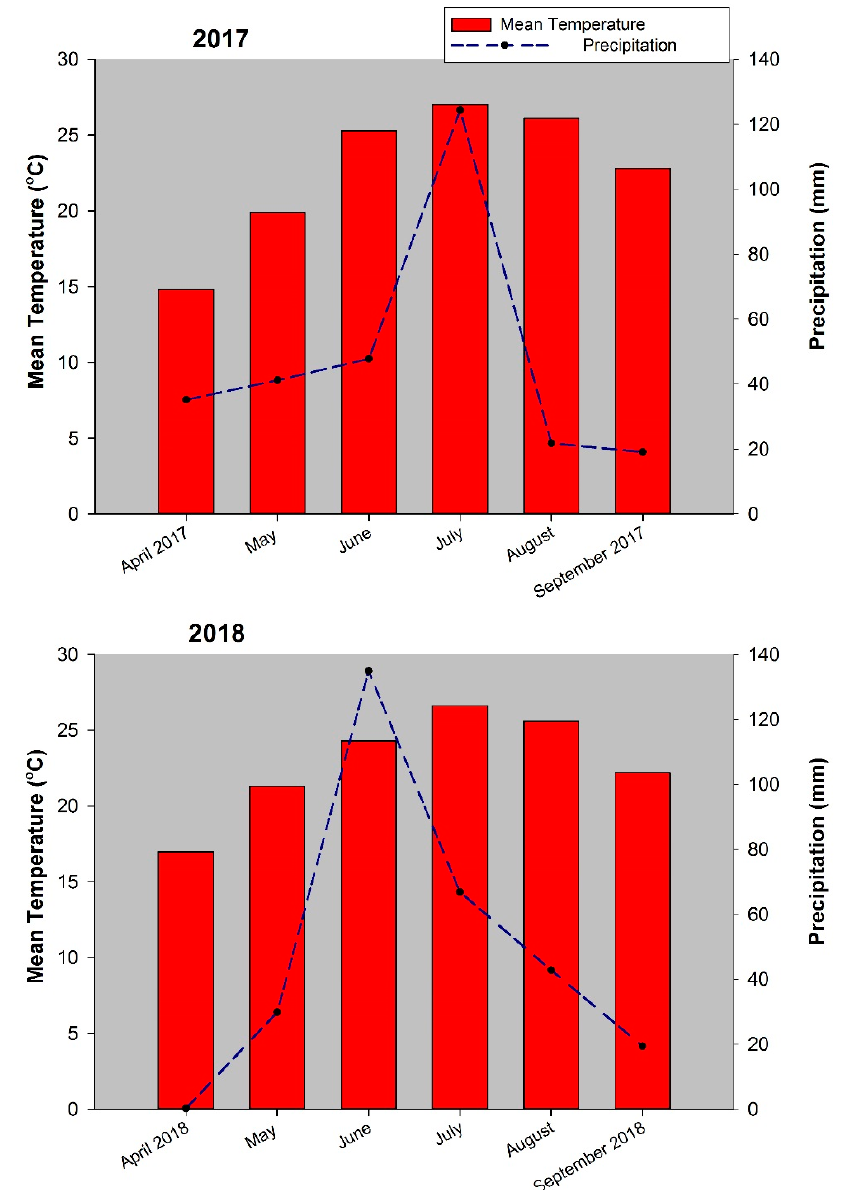
Figure 1. Mean temperature and precipitation in the experimental site (Velestino, Greece) in 2017 and 2018.